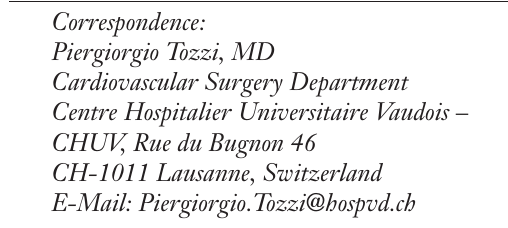
Intraoperative view of pig’s heart. The 30 F defect of the free wall of the left ventri- cle has been repaired using a Nitinol oc- cluder. After sacrifice of the animal, the delivery guide wire is re screwed in the occluder and slightly pulled back for demonstration